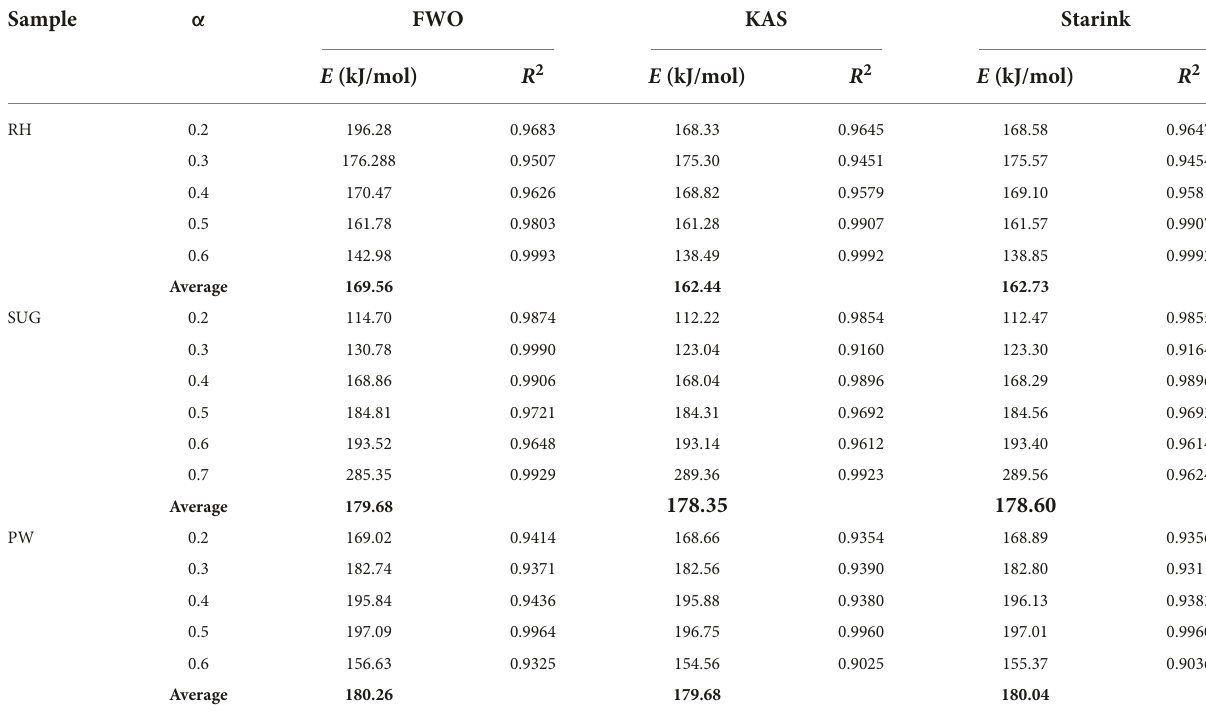
TABLE 4 Kinetics parameters of biomass solved by isoconversional methods.